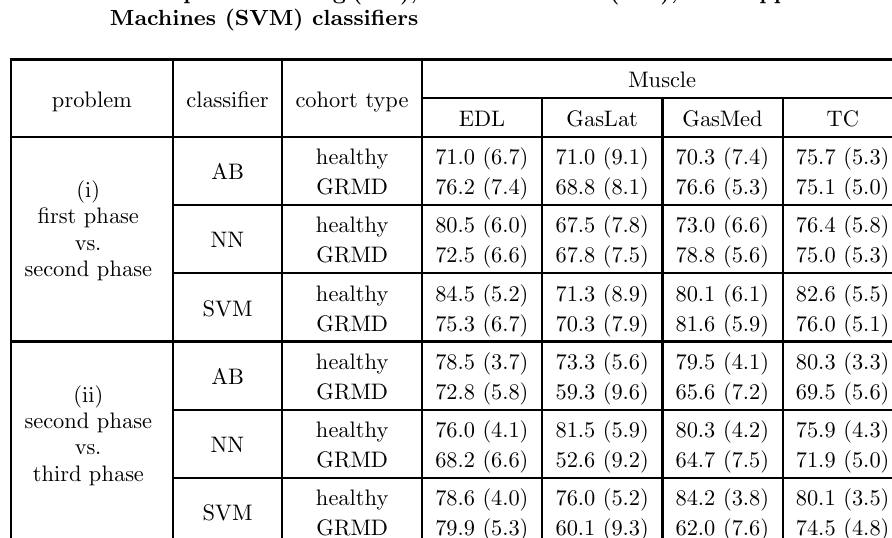
Table 4. Classification accuracies (and standard deviations) [%] achieved with the use of all the 37 initial features, for two differentiation problems: (i) the first phase vs. the second phase and (ii) the second phase vs. the third phase. The experiment consisted in identifying the phase of canine growth in healthy dogs and the phase of dystrophy development in GRMD dogs. The results were obtained by application of Adaptive Boosting (AB), Neural Network (NN), and Support